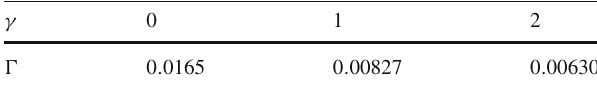
Fig. 6 The electric conductivity σ( ˆ ω) for different γ and the fixed ˆ β = 0 . 25. The dots are the numerical results while the solid lines are fitted by the standard Drude formula (38)